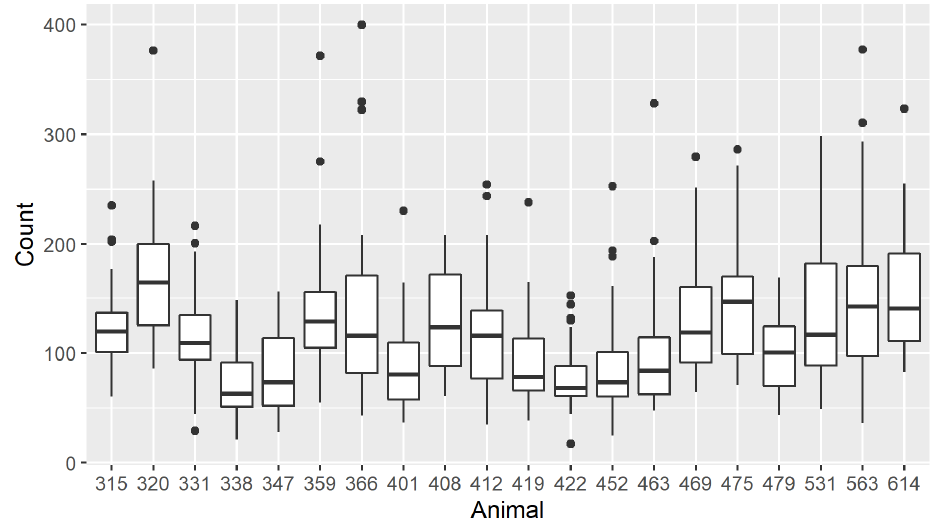
Figure 2. Distribution of P_MEAN (ppm-m) by animal.